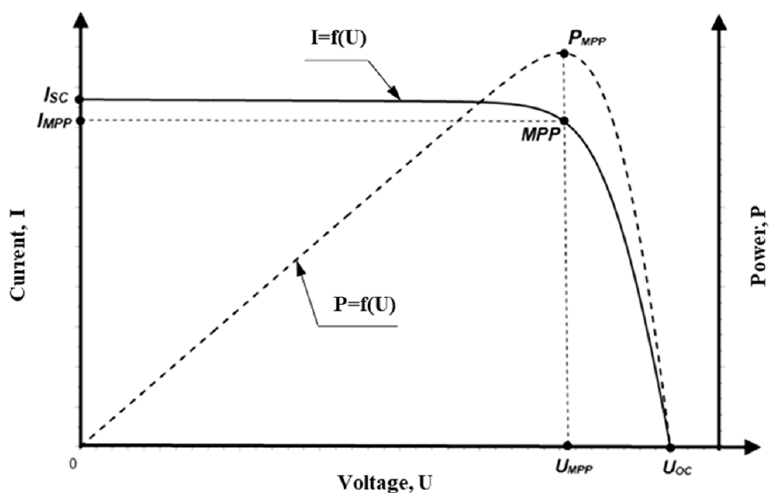
Figure 1. Correct course of the current–voltage (I–V) characteristic of the photovoltaics (PV) module and the interpretation of the maximum power point (MPP) (description of the markings is given in Table 1).